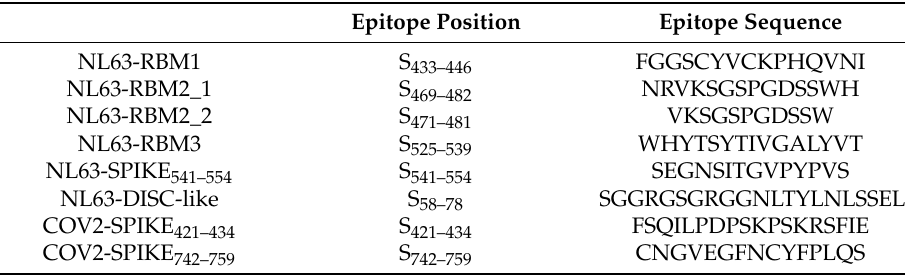
Table 2. Epitopes identified in HCoV-NL63 and